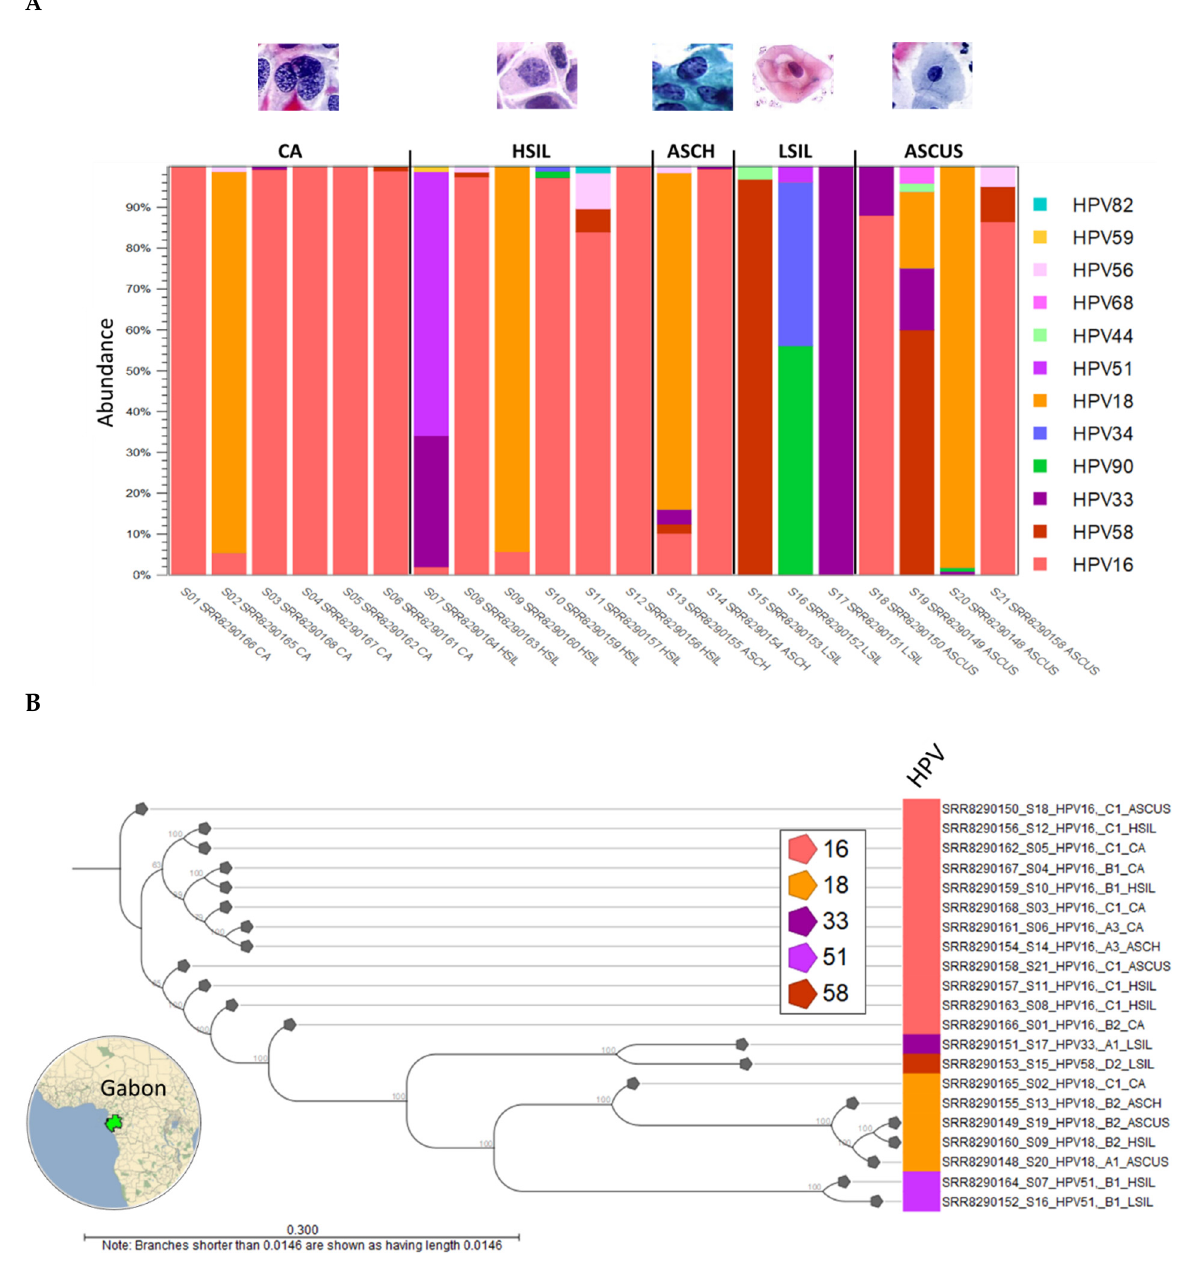
Figure 1. Viral Hybrid Capture (VHC) analysis. ( A ) Relative abundance of HPV genotypes found in individual samples ( n = 21) after taxonomic profiling are shown as stacked bars. The total number of unique HPV genotypes identified in the cohort was 12. HPV type-specific carcinogenicity (carcinogenic, possibly carcinogenic, and not carcinogenic) are colorized in shades of red, blue, and green, respectively (legend); ( B ) The dominant HPV genotype and sub-lineage (alphanumeric) of each sample was genetically distinct with divergent branches in the phylogenetic tree. For the 15 HPV-integrated samples, the dominant and integrated genotypes were identical for 13 samples. Conversely, for S16 and S19, the dominant genotypes were HPV-90 and HPV-58, while the integrated types were HPV-90 and -51 (in tree), and HPV-18 (in tree), respectively. This finding suggests that type-specific insertional potential may prevail over viral counts for an integration event. Representative cytological images (40×) (source: IARC Cytopathology of the uterine cervix—digital atlas [30]).